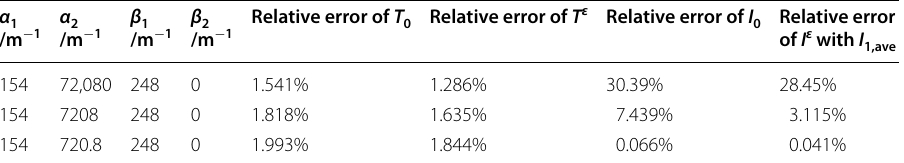
Table 5 Results of the multiscale simulations with different absorption coefficients α 1 α 2 /m − 1 /m − 1